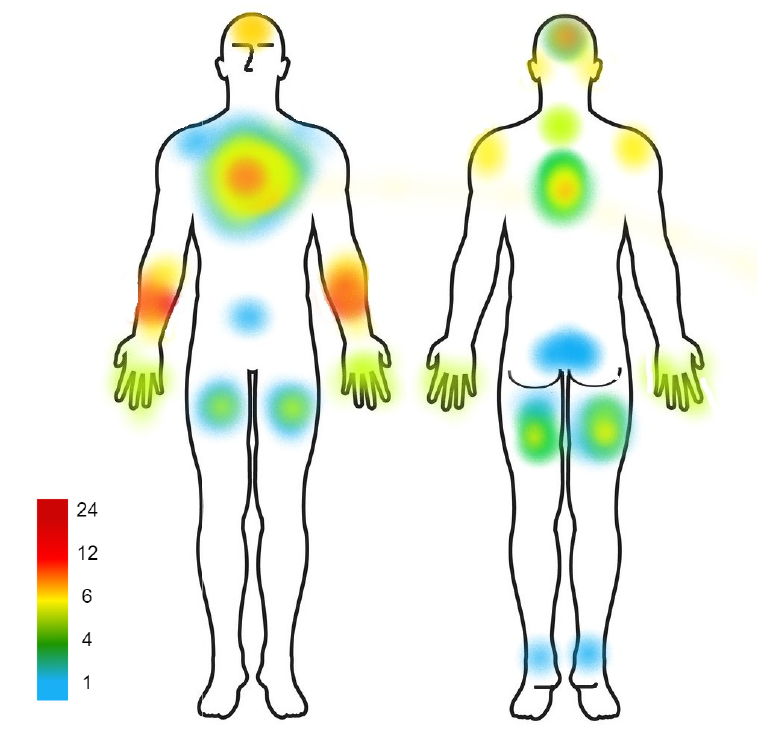
Figure 4. Commonly used body